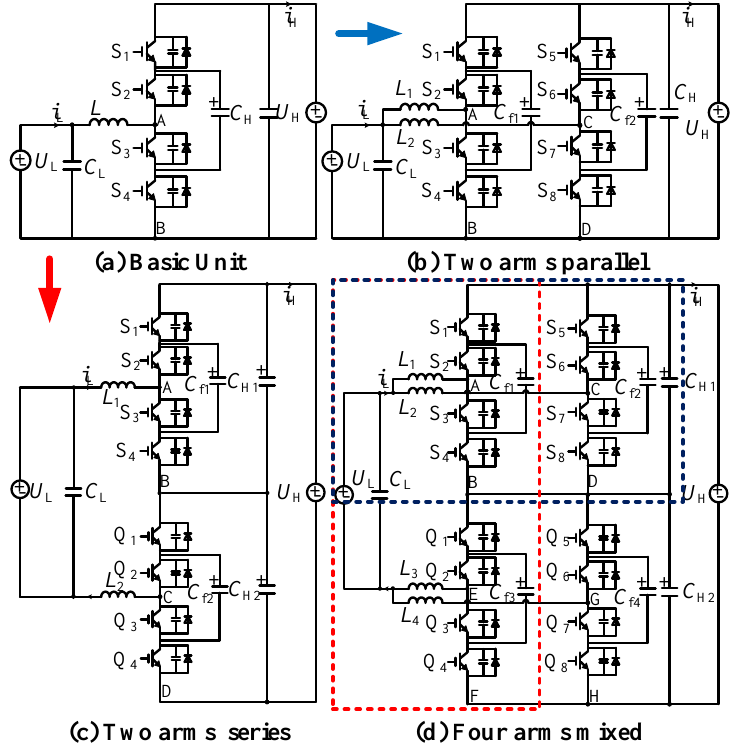
Figure 1. The proposed bidirectional DC/DC converter. ( a ) Flying capacitor type three-level DC-DC basic unit. ( b ) Two basic units parallel. ( c ) Two basic units parallel. ( d ) Four basic units mixed.